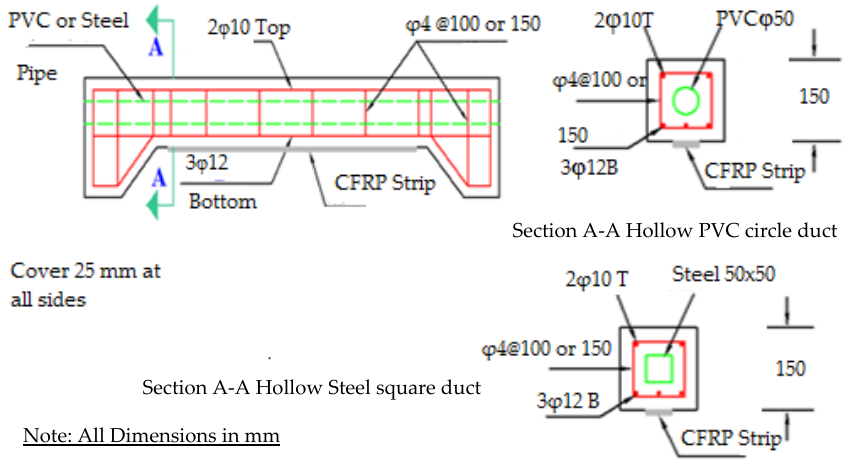
Figure 3. Hollow non-prismatic RC beams with reinforcements and section details [23]. Reprinted from Ref.